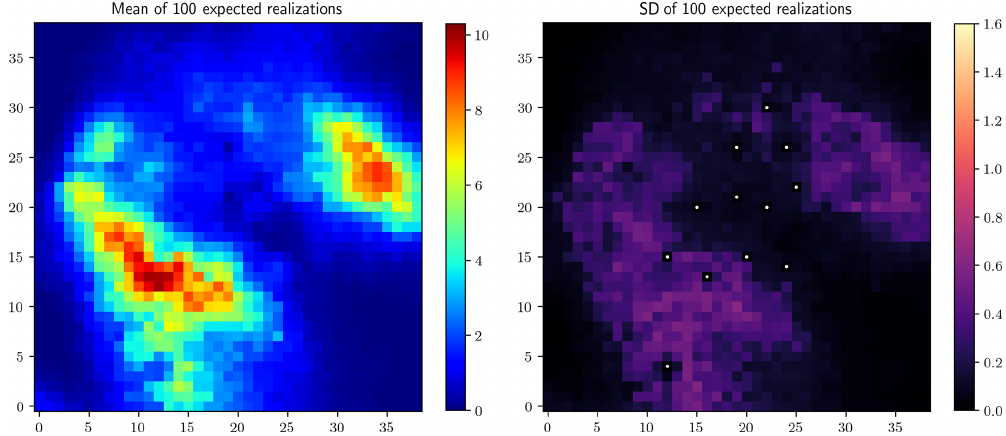
Figure 7. Stage 3 results: mean and standard deviation of 100 expected realizations